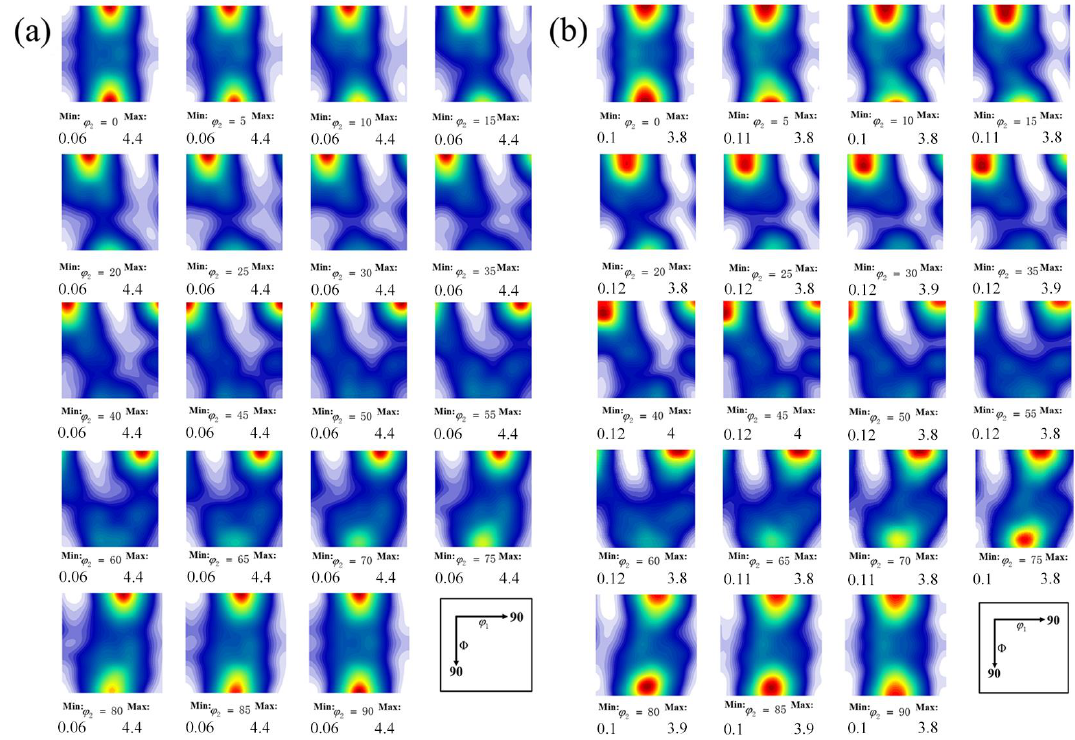
Figure 7. Orientation distribution function sections of as-received NiTi SMA used for describing initial texture: ( a ) based on EBSD experiment; ( b ) based on simulation via 1000 extracted grain orientations.